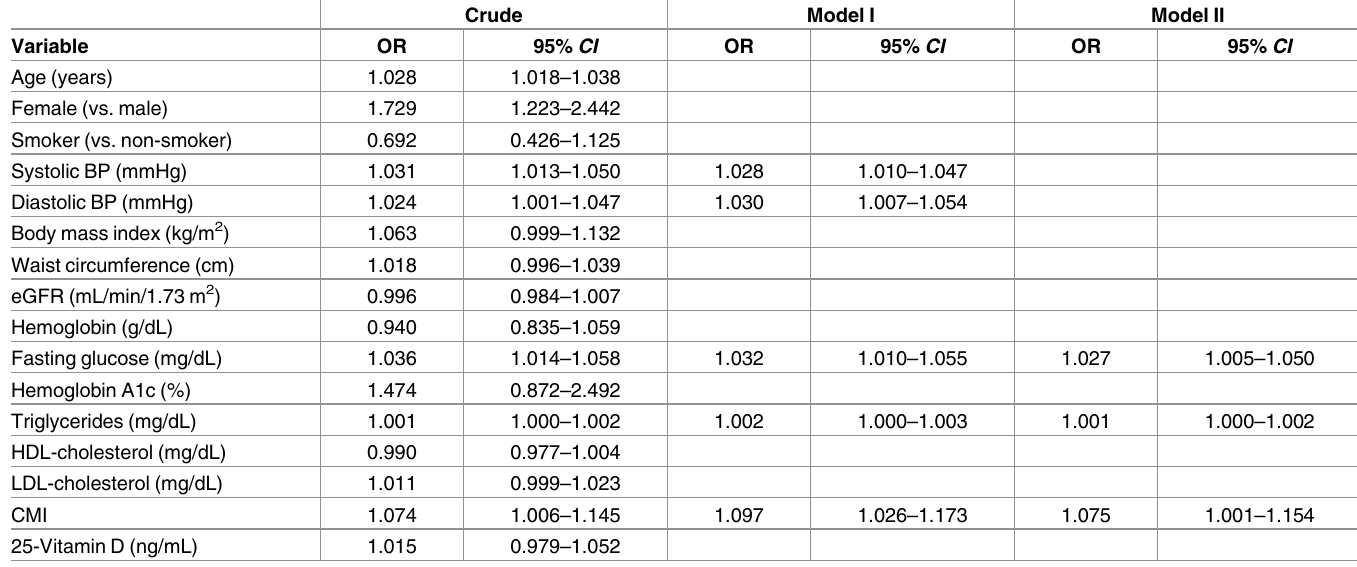
Table 3. Multivariable logistic regression for microalbuminuria *